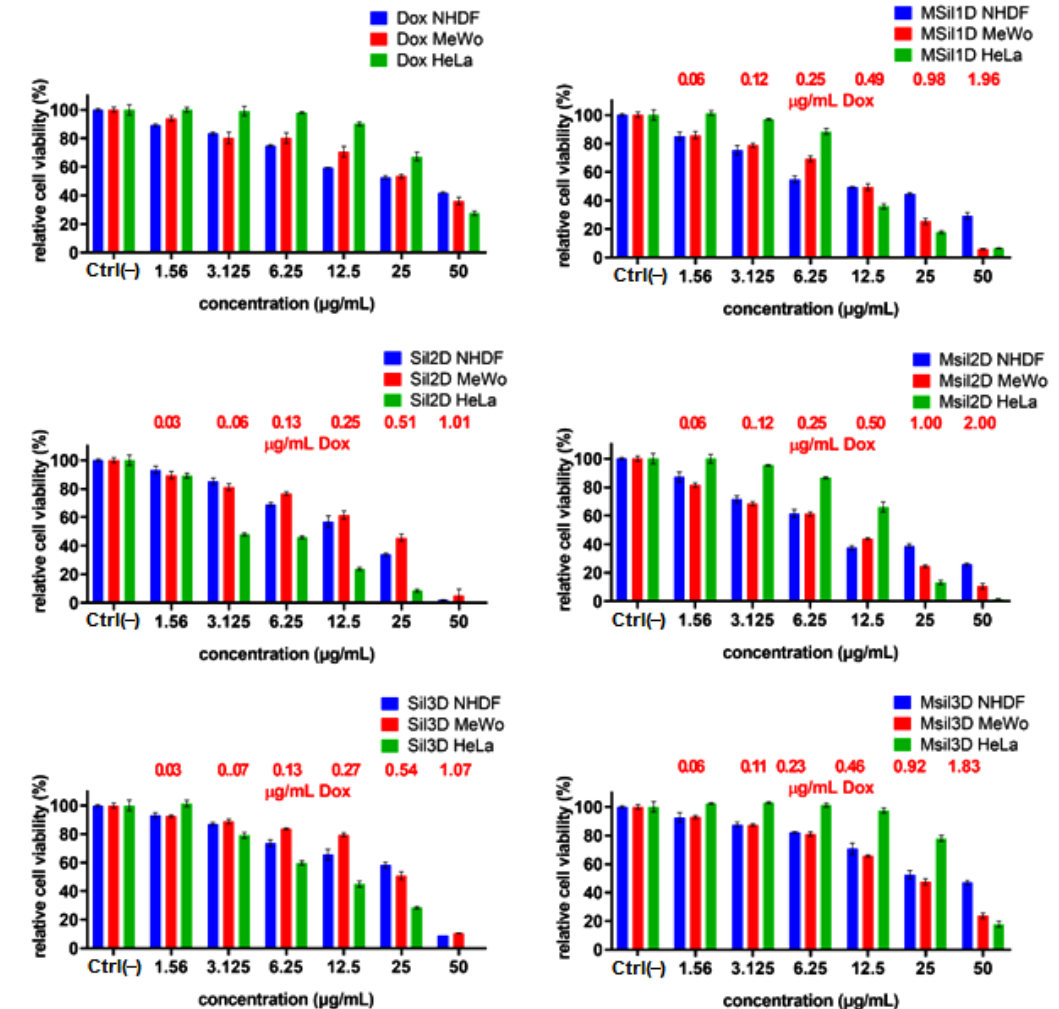
Figure 9. Cell viability in presence of Dox-loaded silicas (the concentrations depicted in red above each graph were calculated taking into account the amount of Dox encapsulated in each silica sample before the viability experiment).